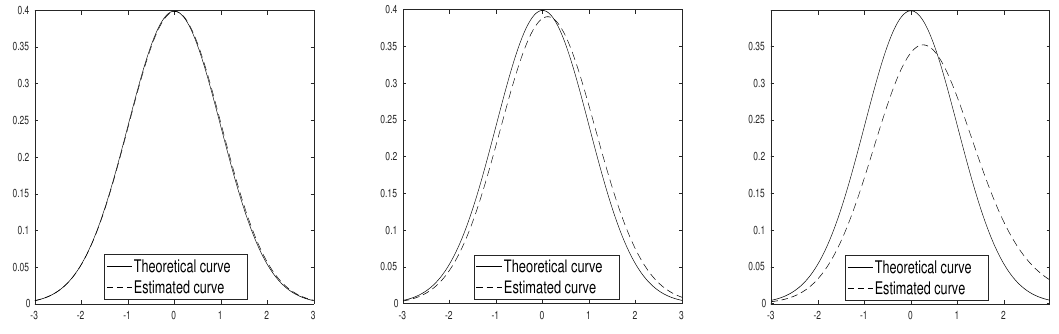
Figure 5: n = 200 and ( ρ 1 , ρ 2 ) = (0.1, 0.8) for CR ≈ 12, 42, 83%